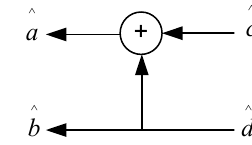
Figure 2: The Kernel decoding